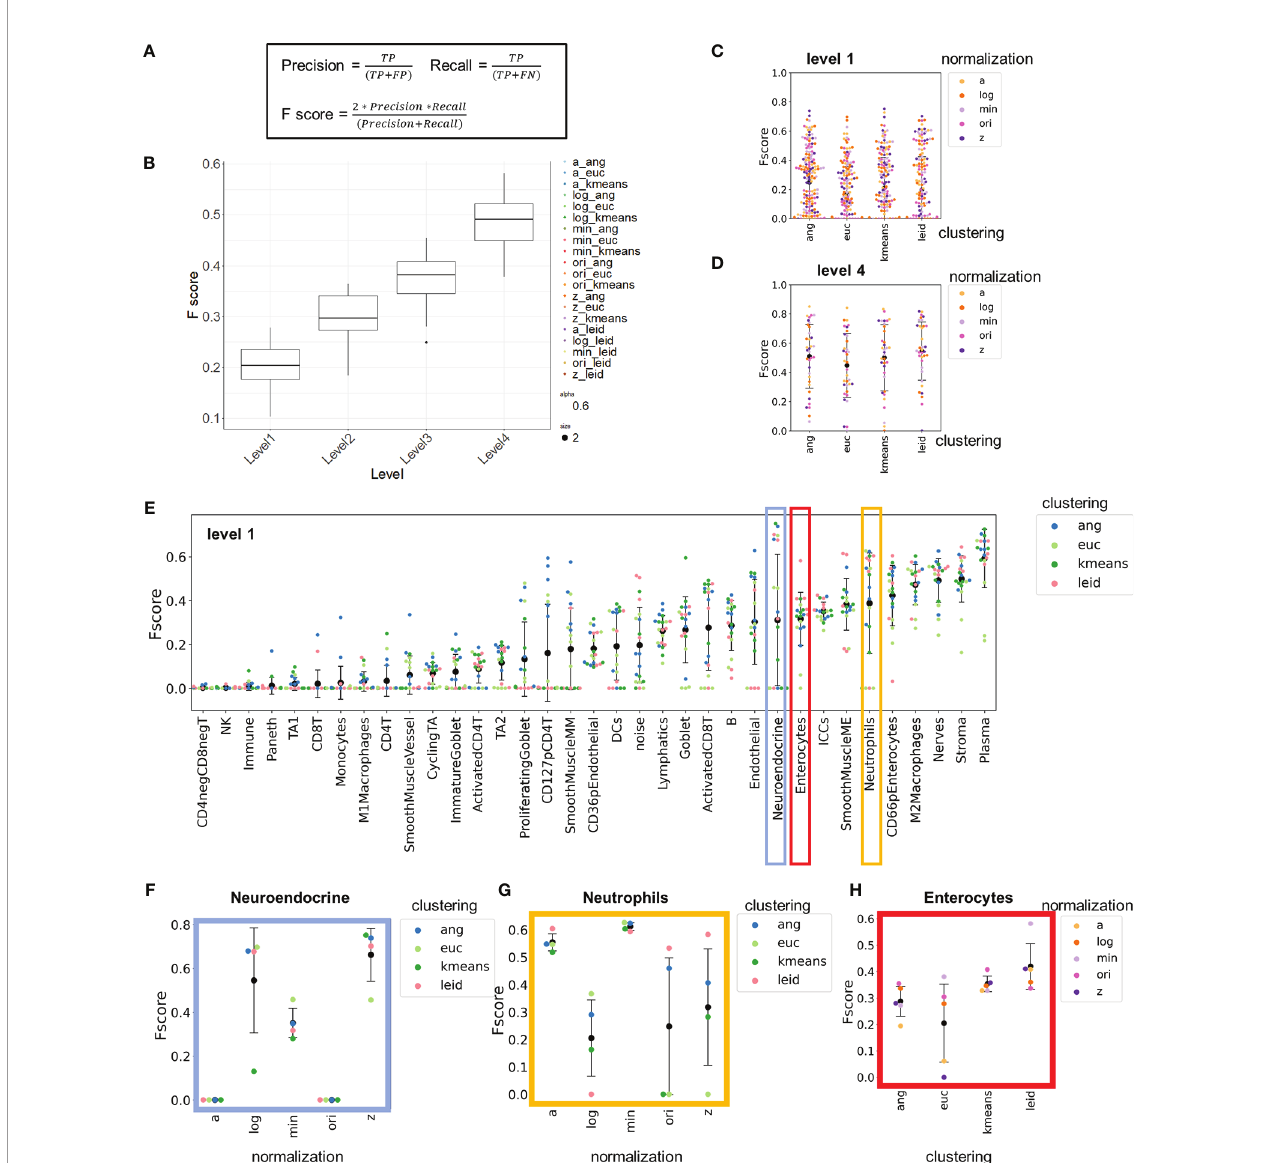
FIGURE 3 | F-score comparisons between clustering and normalization technique to hand-gated standard demonstrate high inter-cellular and high intra-cellular variation. (A) Method for calculating F-scores with cell-type assignments. (B) Average F1 score for each normalization. (C) Clustering combinations strati fi ed by level of granularity. (D) Level 1 and level 4 F-scores averaged across cell types for each combination of normalization technique and clustering algorithm. (E – H) Level 1 F- scores for (E) each cell type and, in expanded views, (F) neuroendocrine cells, (G) neutrophils, and (H) enterocytes pulled out for comparisons of clustering or normalization technique (black data point is mean and error bars indicate standard